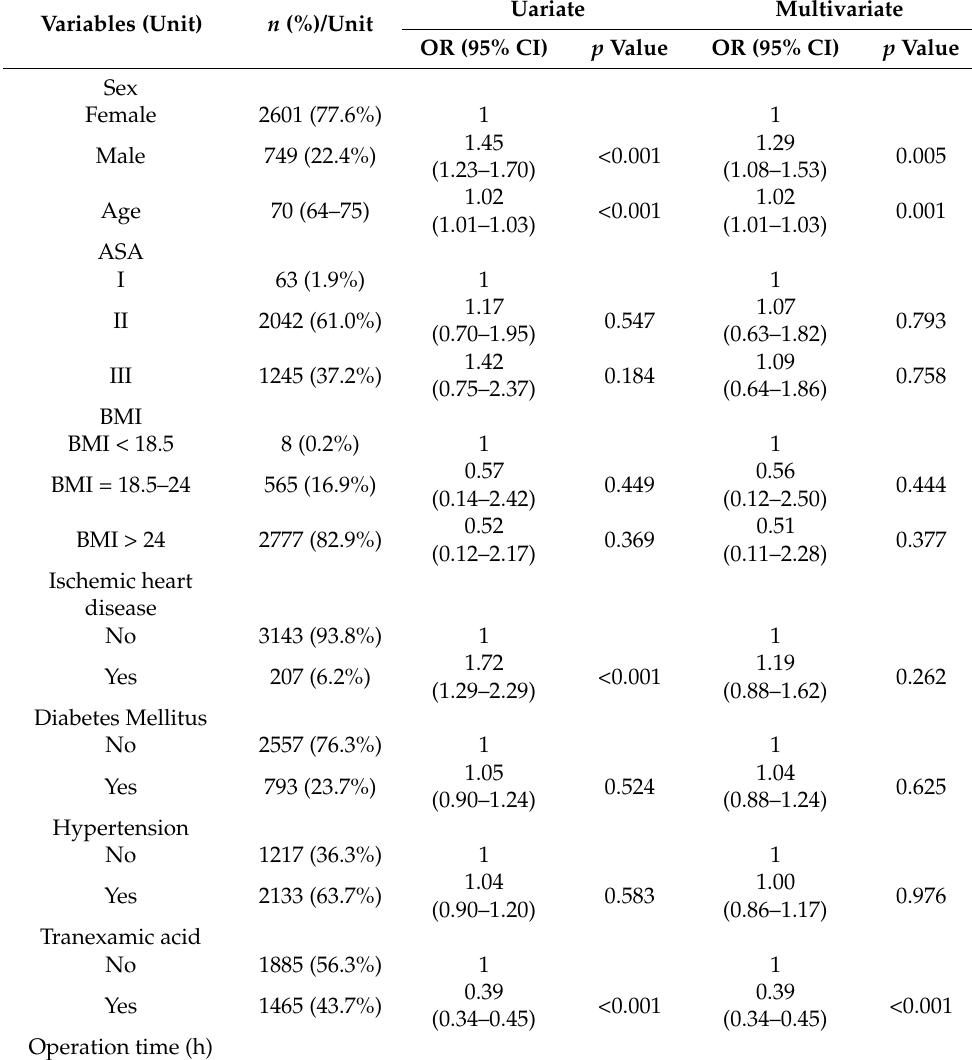
Table 2. Univariate and multiple logistic regression model of the postoperative Hb